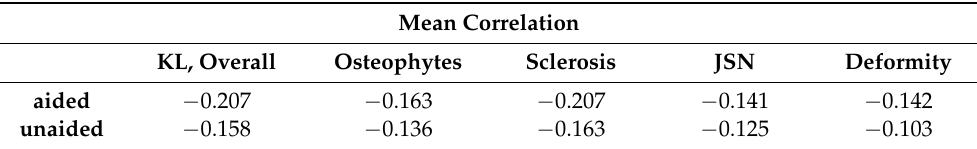
Table 5. Mean correlations of the overall KL score and its sub-scores (JSN = joint-space narrowing; KL =